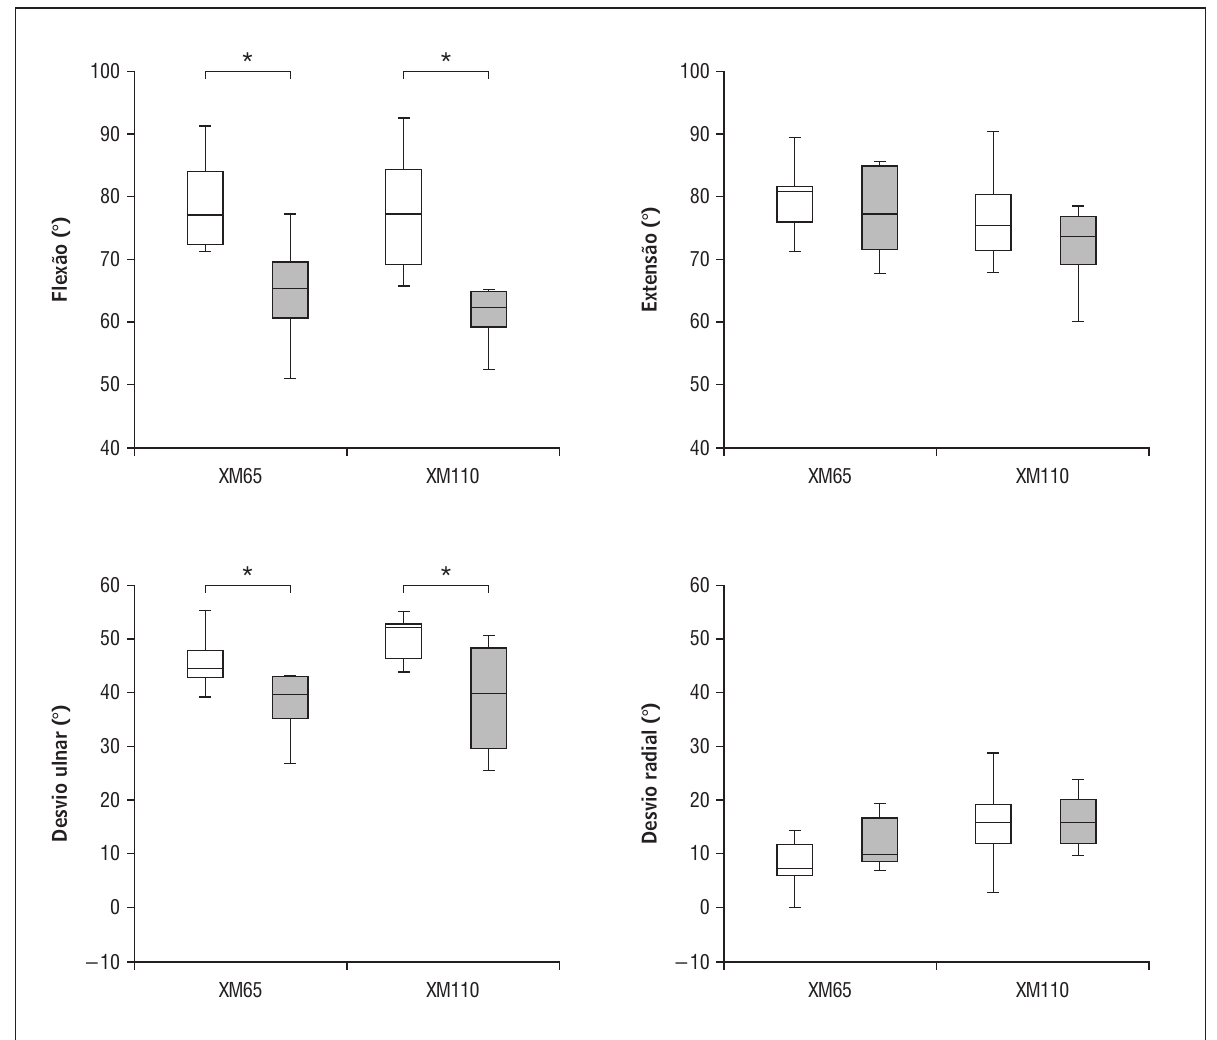
Figura 2 - Ângulos de flexão, extensão, desvio ulnar e radial medidos pelos sensores XM65 e XM110 para o gênero feminino (branco) e gênero masculino (cinza) Legenda: * = p < 0,05 entre os gêneros. Fonte: Dados da